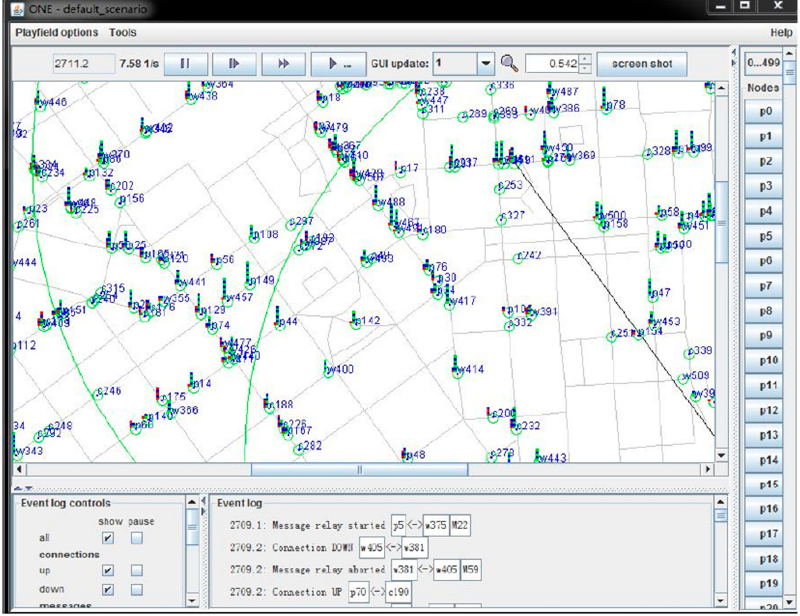
Figure 2. Interactive graphical interface of the emulator.